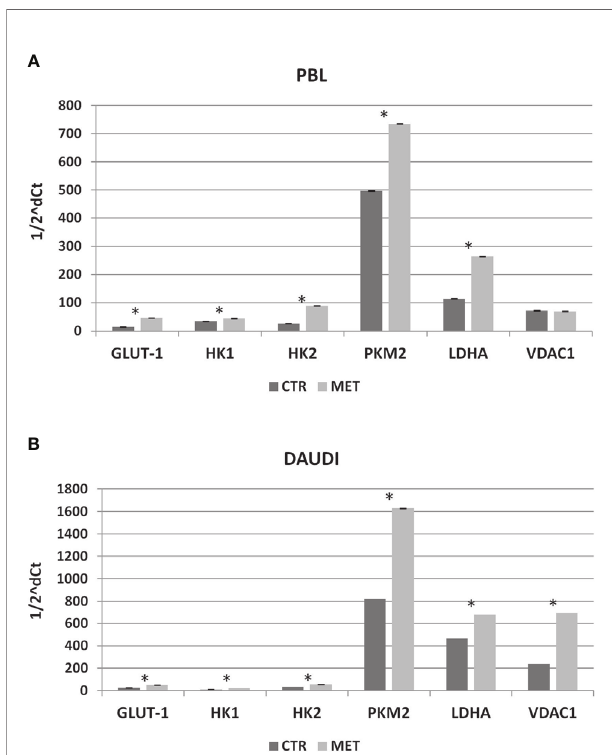
FIGURE 7 | Effect of Metformin on gene expression pro fi le of PBL (A) and DAUDI cells (B) . The effect of metformin on gene expression of selected targets involved in Warburg ’ s effect was evaluated by RT-qPCR after 24 hours of 10 mM metformin treatment in both DAUDI cells and PBL. Beta- actin was used as the reference genes. Values represent fold changes of each target with respect to the untreated control (Wilcoxon matched-pairs signed rank test; *p-values ≤